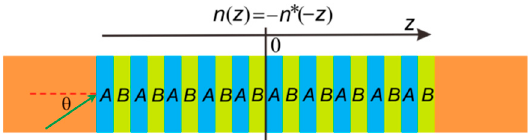
Figure 1. Schematic of the one-dimensional anti-parity–time (PT)-symmetric photonic crystals (PCs), where the complex refractive indices are distributed in n ( z ) = n ( − z ). For the primitive unit cell layers A and B, the thickness is d = 125 μ m and the complex refractive indices are n + ∆ n + 0.01 qi, and n − ∆ n + 0.01 qi , respectively. The imaginary part is positive for gain material and negative for loss material.